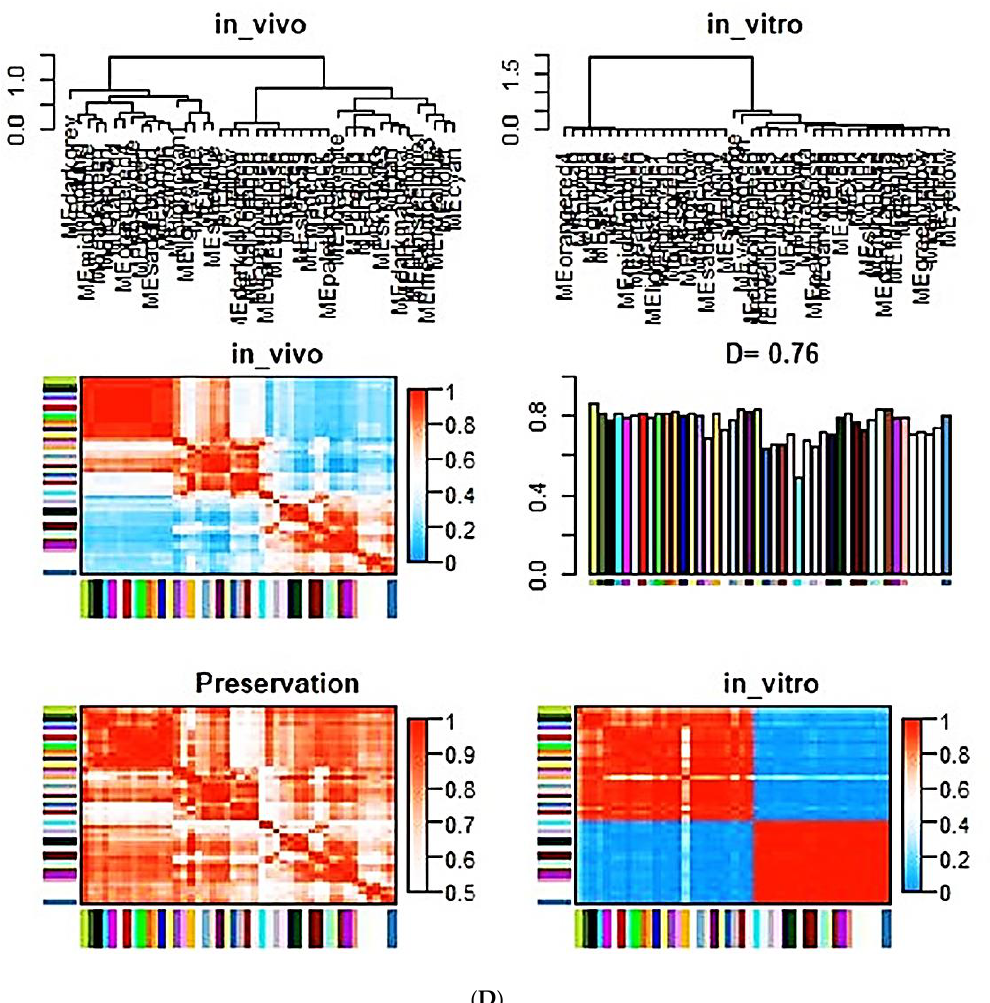
Figure 8. ( A ) Consensus network from in vitro experiments involving exposure to IS or oxLDL. Gene dendrogram obtained by average linkage hierarchical clustering for in vitro (IS and oxLDL) treatments. Gene expression similarity was determined using a pair-wise weighted correlation metric, and clustered according to a topological overlap metric into modules; assigned modules are colored at the bottom, gray genes are unassigned to a module. ( B ) Summary plot of consensus eigengene networks and their differential analysis from IS and oxLDL datasets. Top panels show clustering of consensus eigengenes in IS and oxLDL groups. Next, heat maps show high (red) and low (or negative, green) adjacency. Preservation heat map is 1-absolute difference of the eigengene networks in the two sets. Bar plot shows mean preservation of adjacency for each eigengene to other eigengenes with a D value calculated as the arithmetic mean of these measurements. ( C ) Consensus network from in vivo (PNx model) and in vitro experiments (both IS and oxLDL datasets). Gene dendrogram obtained by average linkage hierarchical clustering for in vivo and in vitro experiments. Gene expression similarity was determined using a pair-wise weighted correlation metric, and clustered according to a topological overlap metric into modules; assigned modules are colored at the bottom, gray genes are unassigned to a module. ( D ) Summary plot of consensus eigengene networks and their differential analysis from in vivo and in vitro (both IS and oxLDL) datasets. Top panels show clustering of consensus eigengenes in the two groups. Next, heat maps show high (red) and low (or negative, green) adjacency. Preservation heat map is 1-absolute difference of the eigengene networks in the two sets. Bar plot shows mean preservation of adjacency for each eigengene to other eigengenes with a D value calculated as the arithmetic mean of these